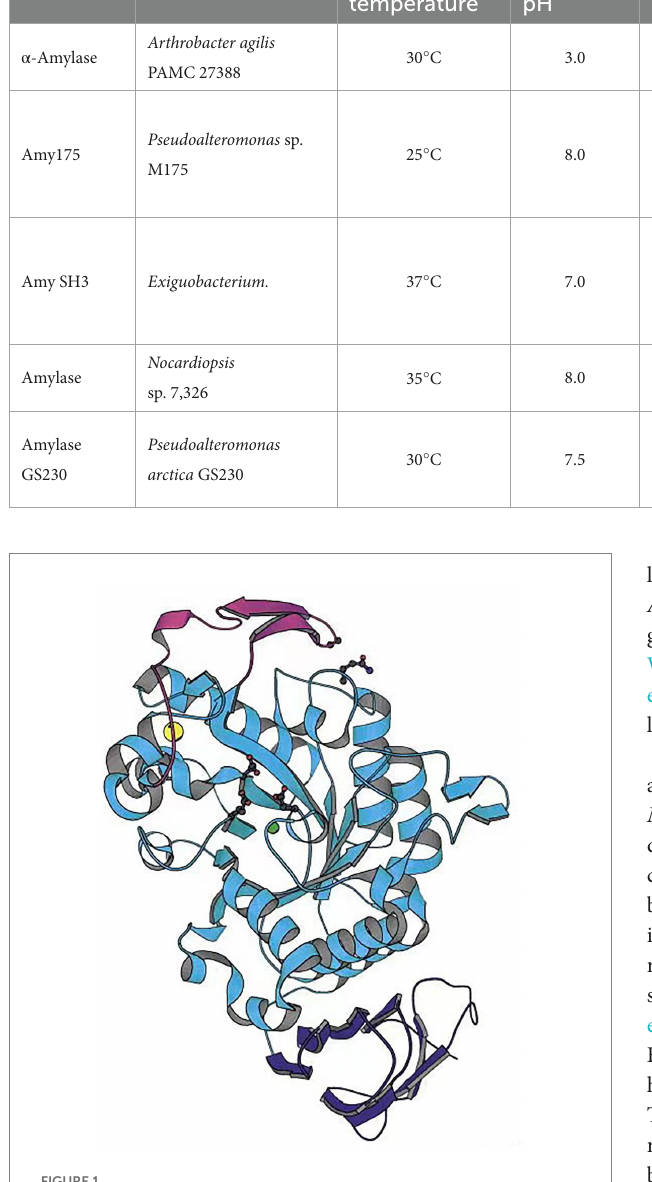
FIGURE 1 Cold-adapted α -amylase from Alteromonas haloplantis structure (Aghajari et al.,